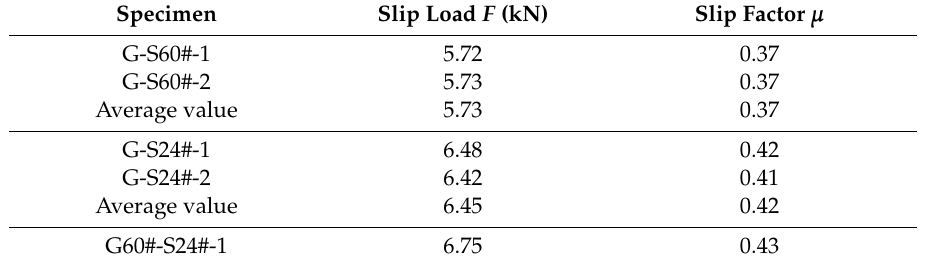
Table 8. The slip load and slip factor values of the tested connections with different grit-blasting treatments. Specimen